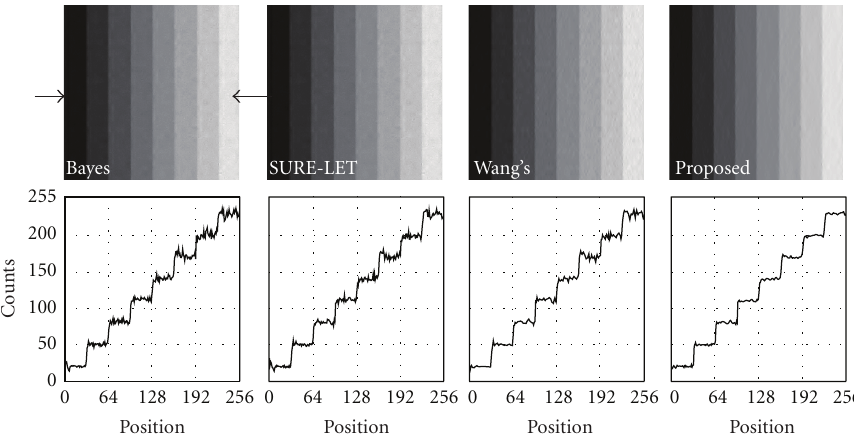
Figure 3: Denoised image of the staircase phantom. From left to right, BayesShrink, SURE-LET, Wang’s method and our proposed method. The profile along a line indicated with two arrows is shown below each image.